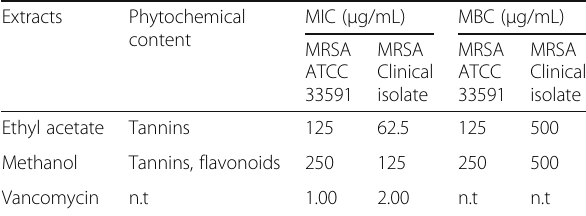
Table 2 Minimum inhibitory concentration (MIC),